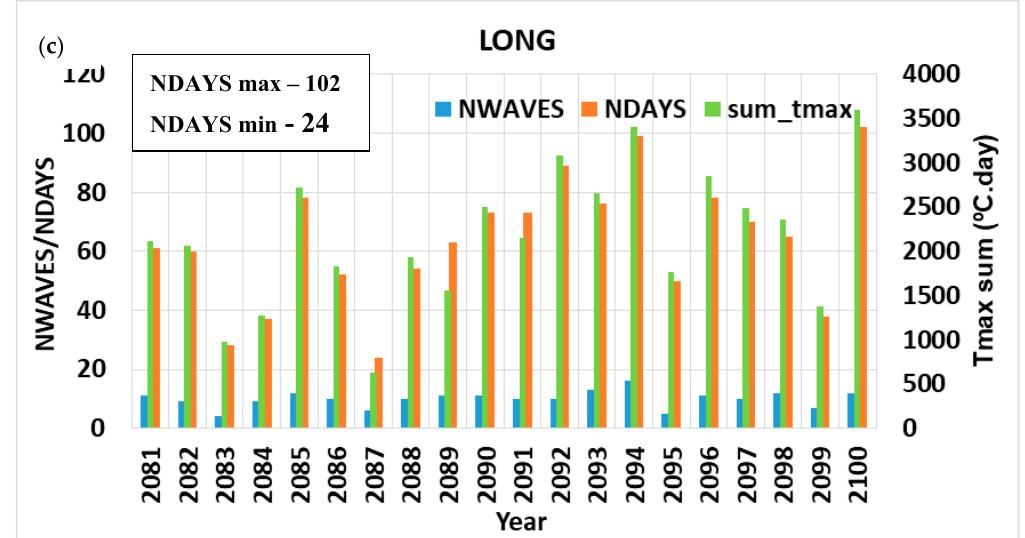
Figure 12. Annual total NWAVES, NDAYS, and Tmax_sum for ( a ) HIST, ( b ) MED, and ( c ) LONG. Minimum and maximum NDAYS are shown in the top left of each figure.